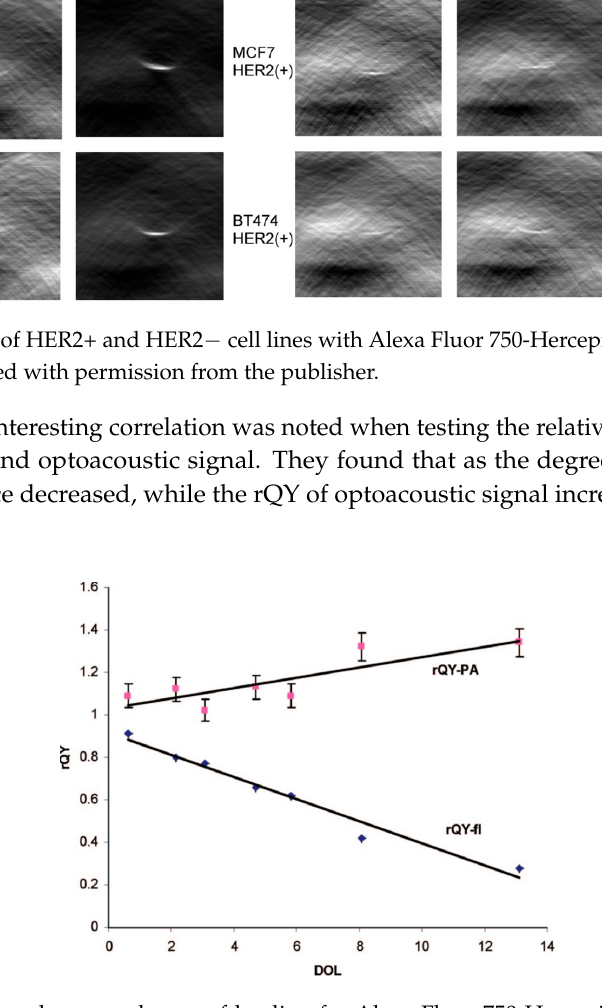
Figure 11. rQY dependence on degree-of-loading for Alexa Fluor 750-Hercepin conjugate. Figure from [92] reproduced with permission from the publisher.